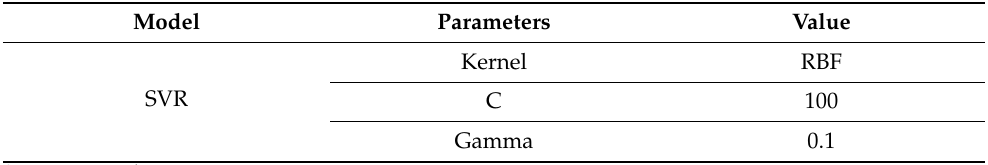
Table 1. Hyperparameters of SVM